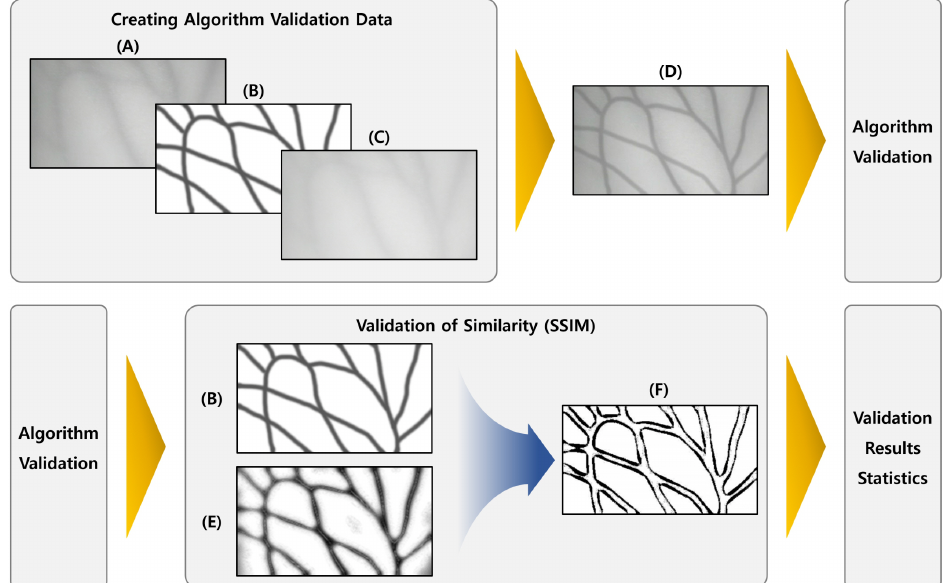
Figure 14. Algorithm verification method using the dataset for verification of the vein image pro- cessing algorithm: ( A ) is the original image, and ( C ) is the original image with 85% transparency applied. ( B ) is an artificial blood vessel layer added for verification, and ( D ) is a composite image of ( A – C ). ( E ) is the result image obtained through the algorithm, and ( F ) is the result image obtained by comparing ( B , E ) with